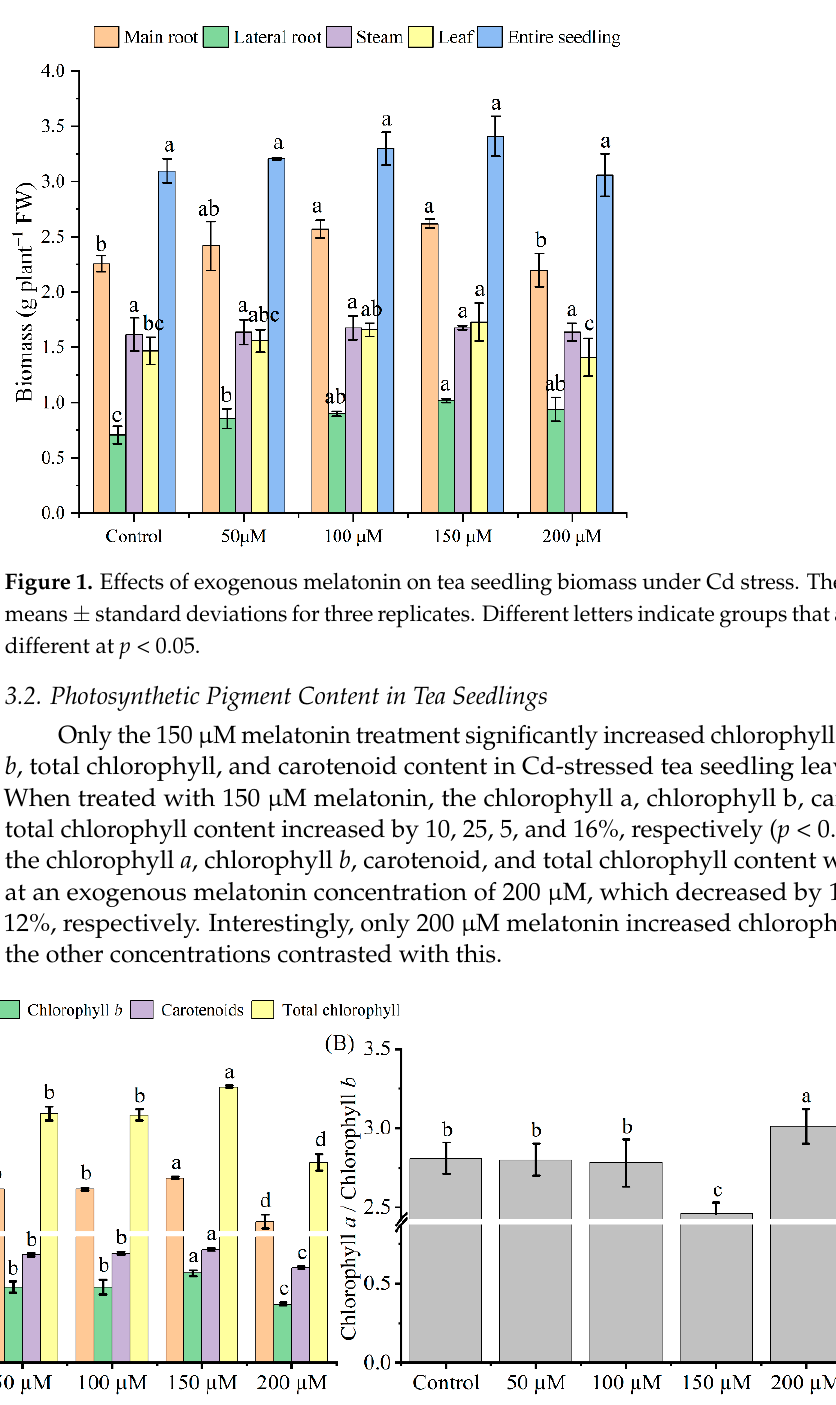
Figure 2. Effects of exogenous melatonin on photosynthetic pigments ( A ), as well as the ratio of chlorophyll a and chlorophyll b ( B ) in Cd-stressed tea seedlings. The data represent means ± standard deviations for three replicates. Different letters indicate groups that are significantly different at p <